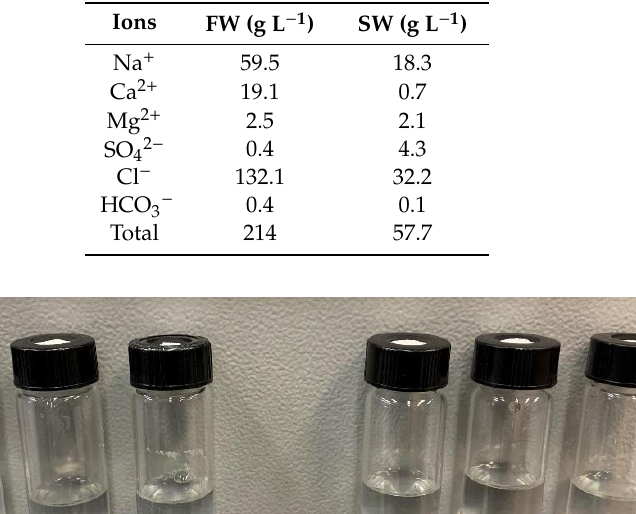
Table 5. The composition of seawater and formation water.